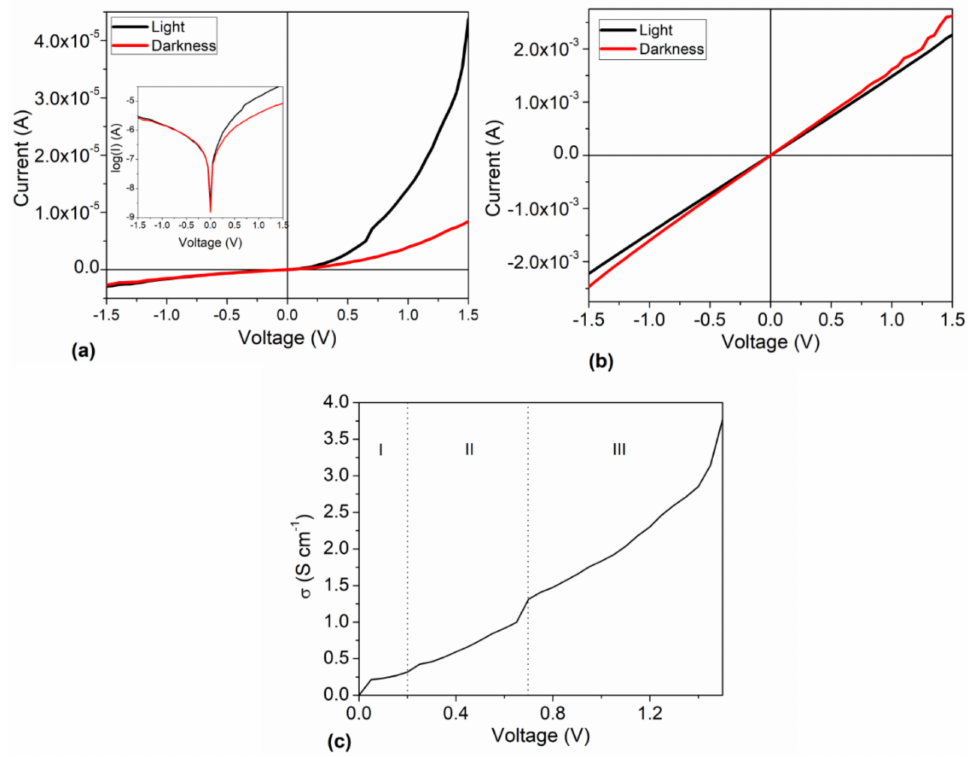
Figure 7. I–V graphs in light and dark conditions for ( a ) PEDOT:PSS-CuBi 2 O 4 NP and ( b ) PEDOT:PSS devices. ( c ) σ –V graphs in light conditions for PEDOT:PSS-CuBi 2 O 4 NP